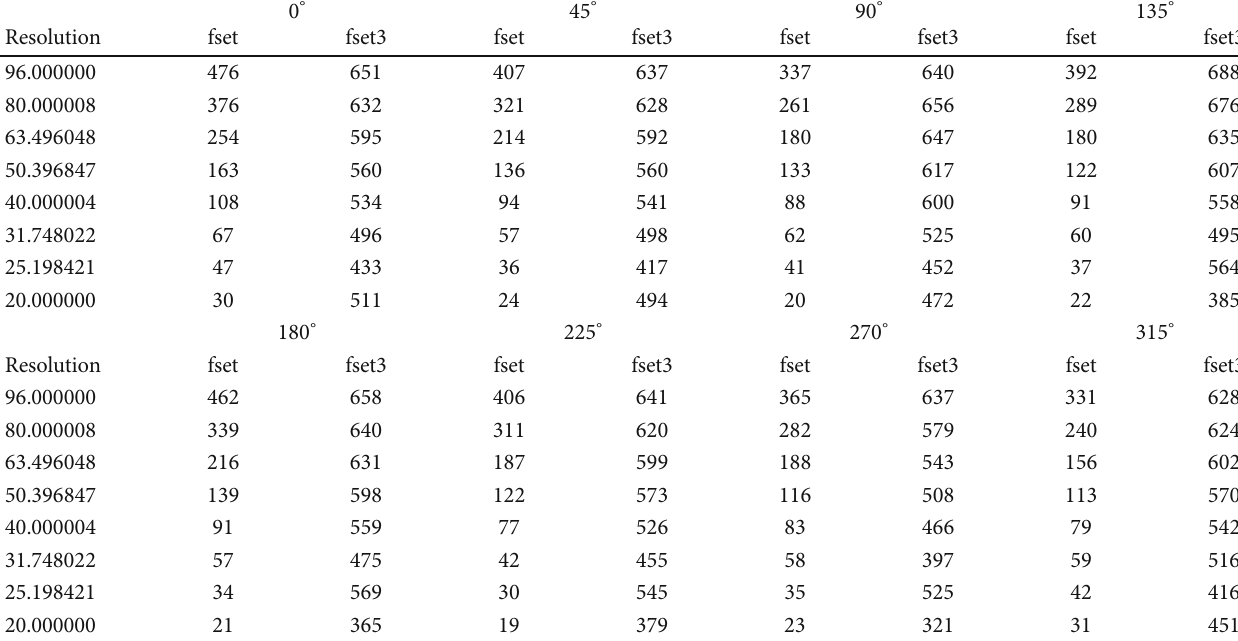
Table 1: Number of feature points with di ff erent resolutions in di ff erent angle